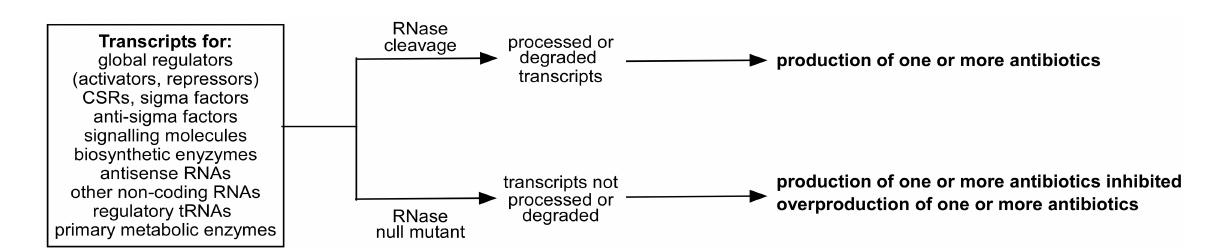
FIGURE 3 Proposed mechanism for the action of RNases on the transcripts of the various regulatory factors that have been shown to be involved in the regulation and production of antibiotics in Streptomyces . The model proposes that any of the transcript classes shown might be targets for RNase processing or degradation and that the effects of the RNases would then impact antibiotic